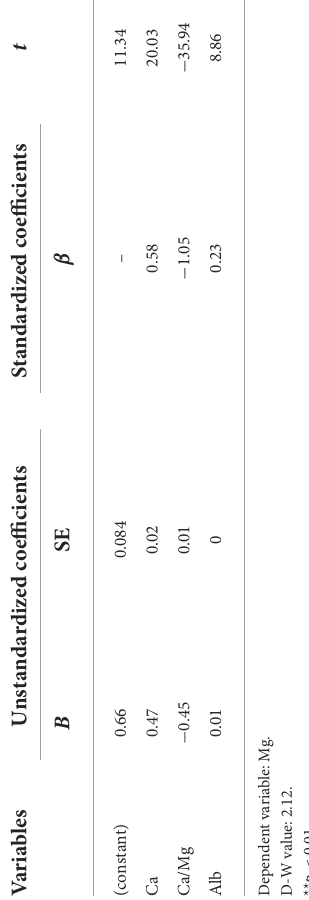
between HD and PD patients Compared to the mineral levels of HD and PD patients, the mean serum Mg levels of HD patients (0.99 ± 0.19 mmol/L) were higher than in PD patients (0.86 ± 0.20 mmol/L; p patients were also higher than in PD patients (all p <